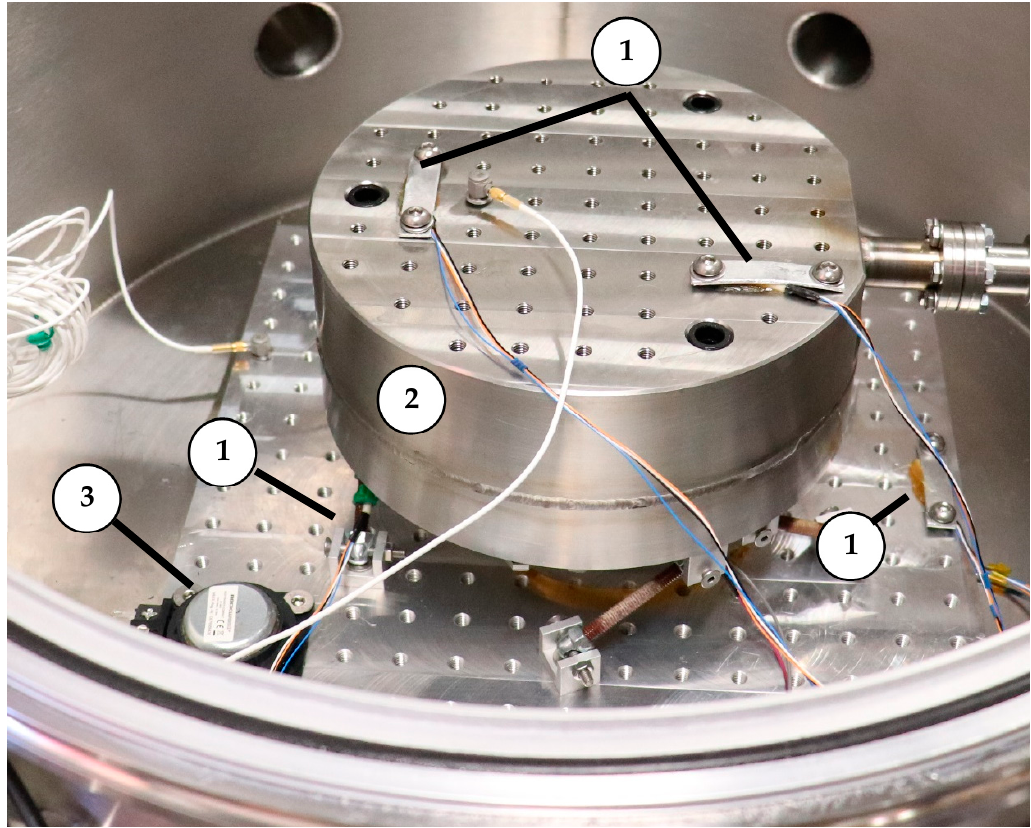
Figure 18. Sensors mounted on the cold plate structure: ( 1 ) PT100 temperature sensors, ( 2 ) vertically oriented accelerometers, and ( 3 ) an electromagnetic shaker.